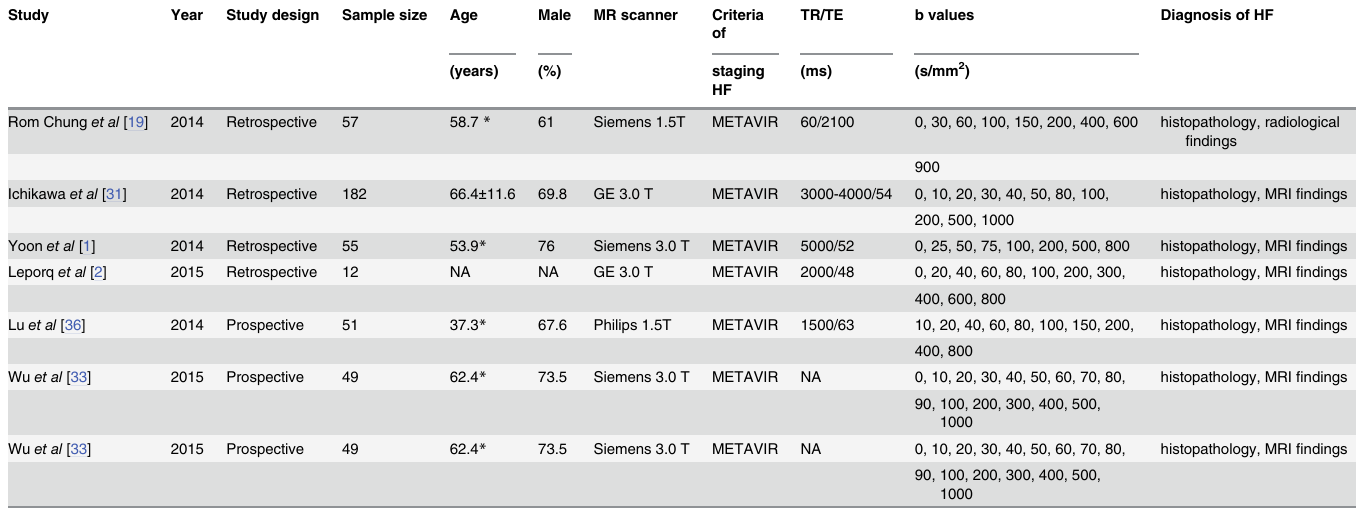
Table 1. The baseline characteristics of included studies and patients.